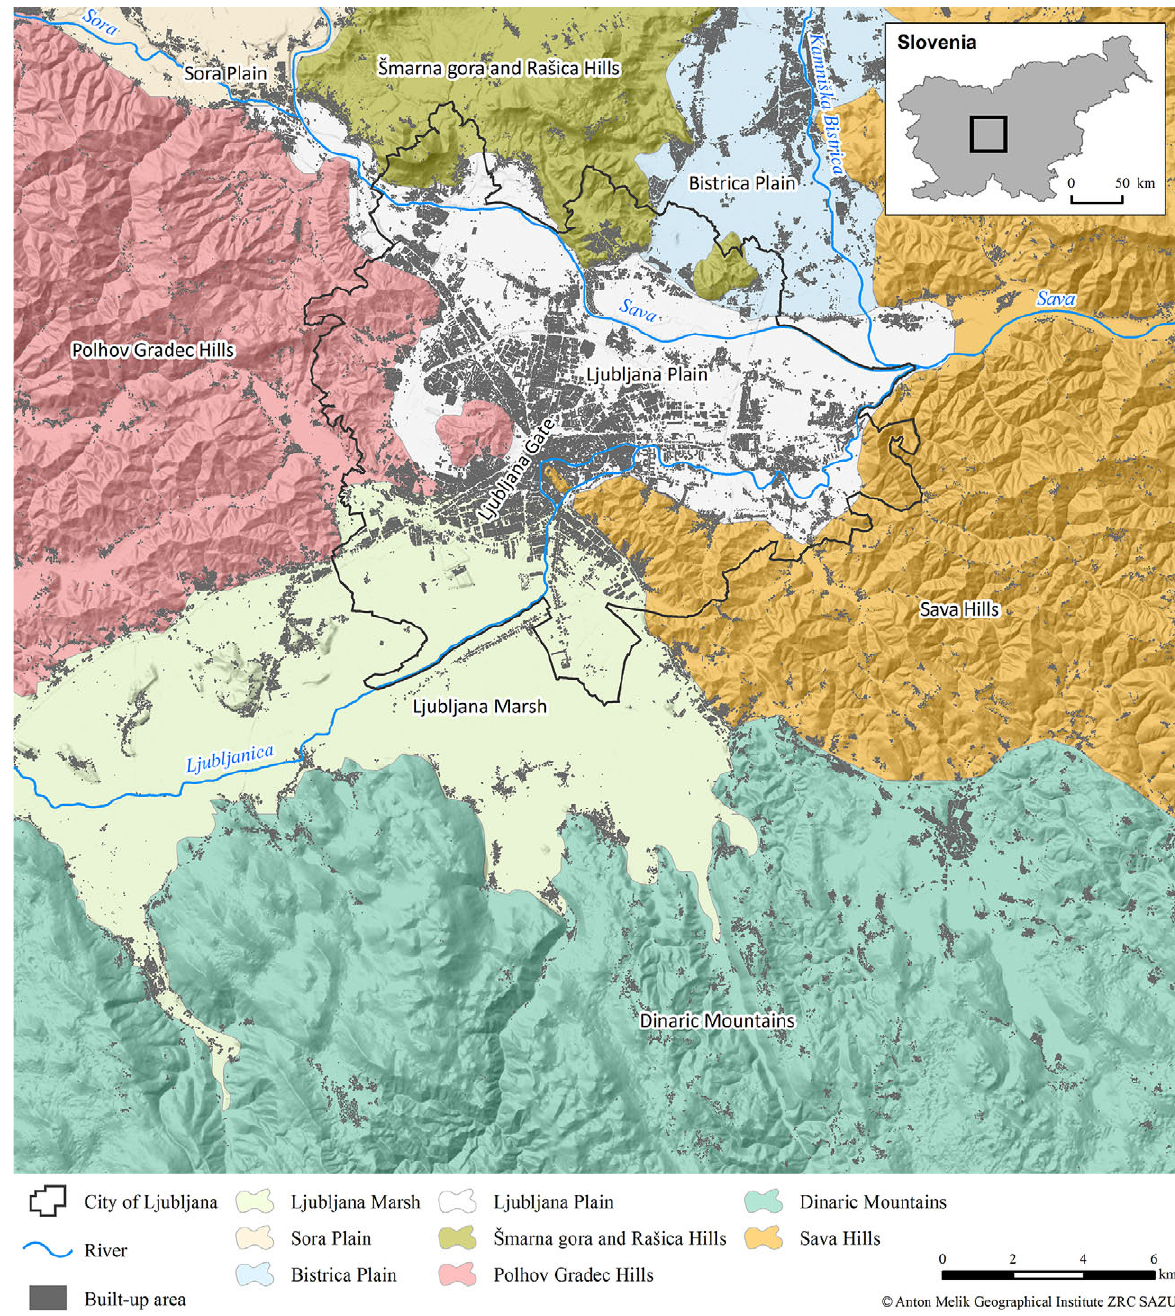
Fig. 1. The city has spread across the flood-safe areas of the Ljubljana Plain to the north and the flood-prone areas of the Ljubljana Marsh to the